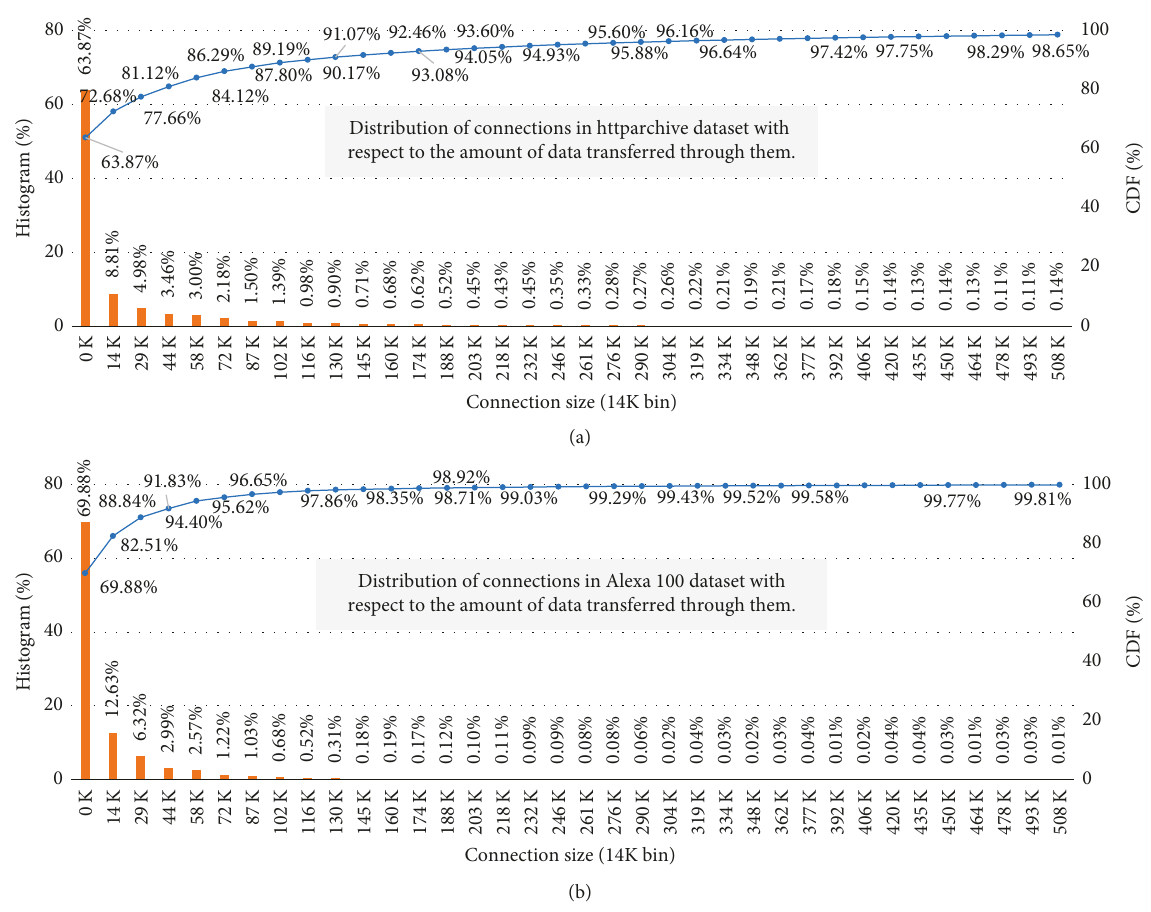
Figure 3: Comparison of connection sizes distributions in homepage of Alexa 100 sites with the larger dataset of